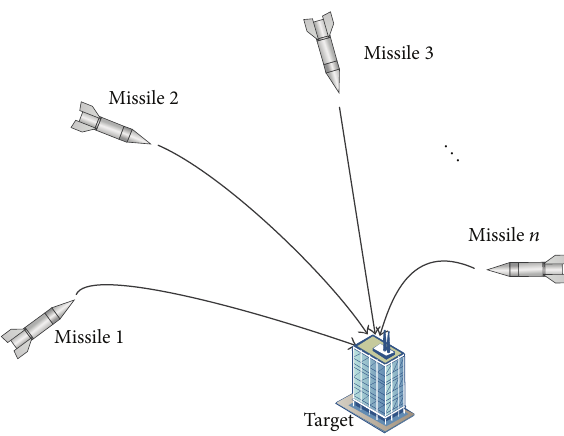
Figure 2: The concept map of multimissiles cooperative saturation